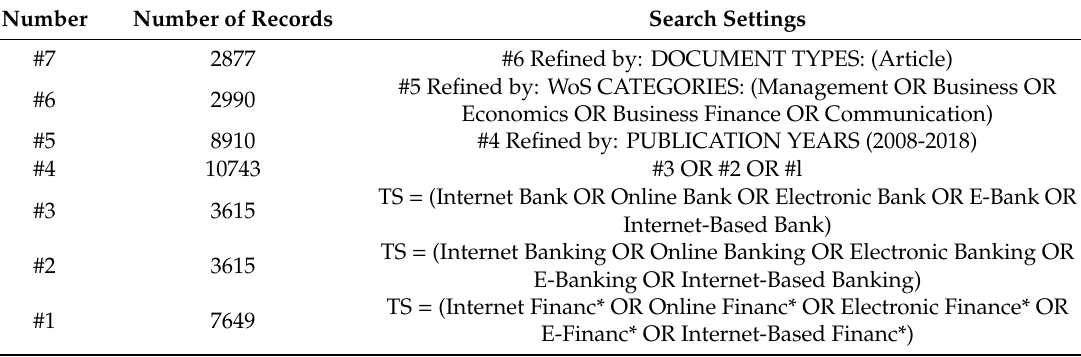
Table 1. The search results of Internet finance in Web of Science